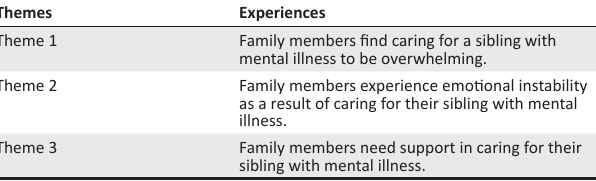
TABLE 2: Themes of family members’ experiences caring for a sibling with mental illness. Themes Experiences Theme 1 Family members find caring for a sibling with mental illness to be overwhelming. Theme